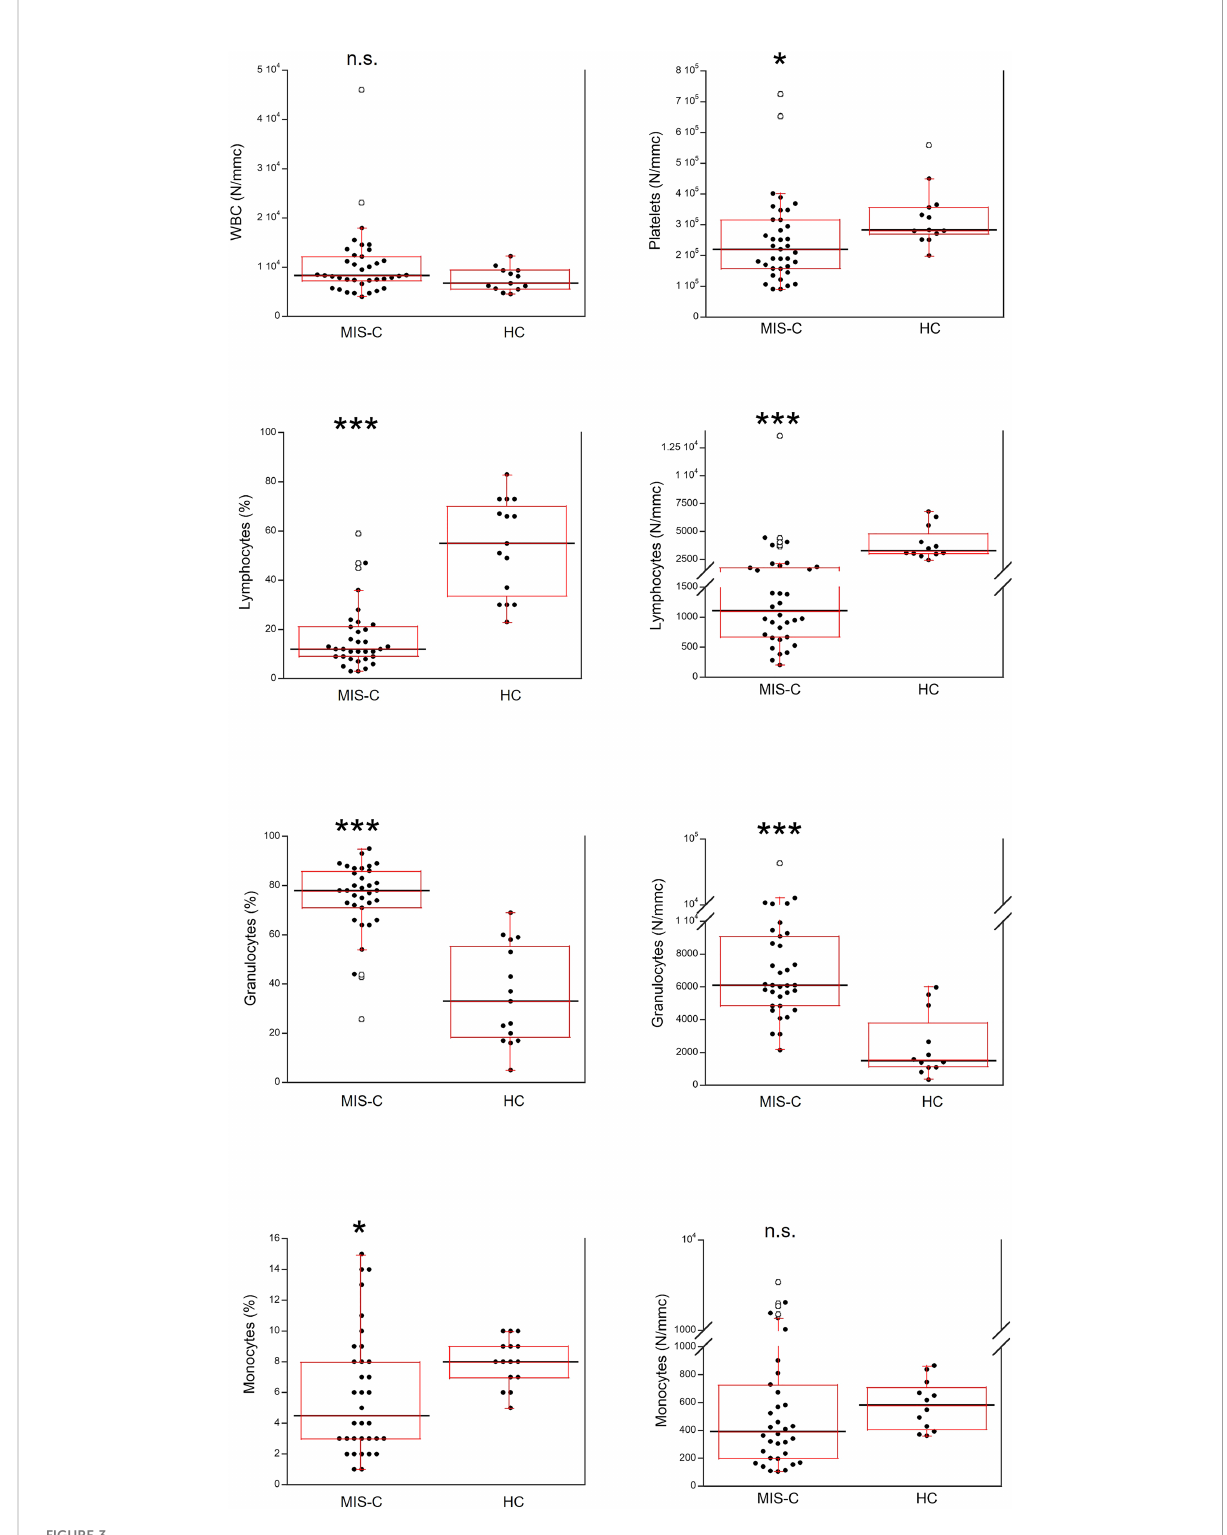
FIGURE 3 Comparison of the complete blood count (CBC) in 37 patients with MIS-C and in 24 HC. The black line represents the median value. The red box represents the interquartile range. The blank circles correspond to the outliers and the black circles side by side to these correspond to duplicates *p < 0.01; ***p < 0.0001; n.s.: not signi fi cant (p >